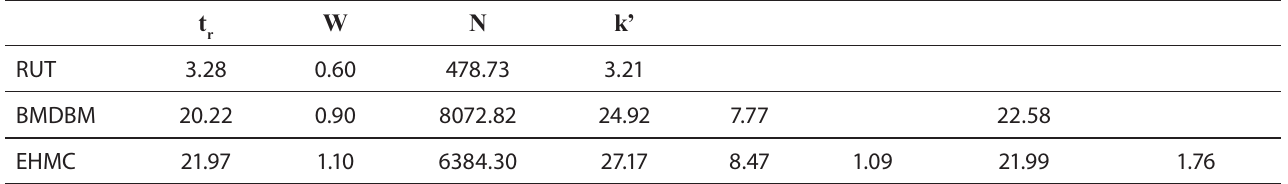
, t , W, k’, α, and m r